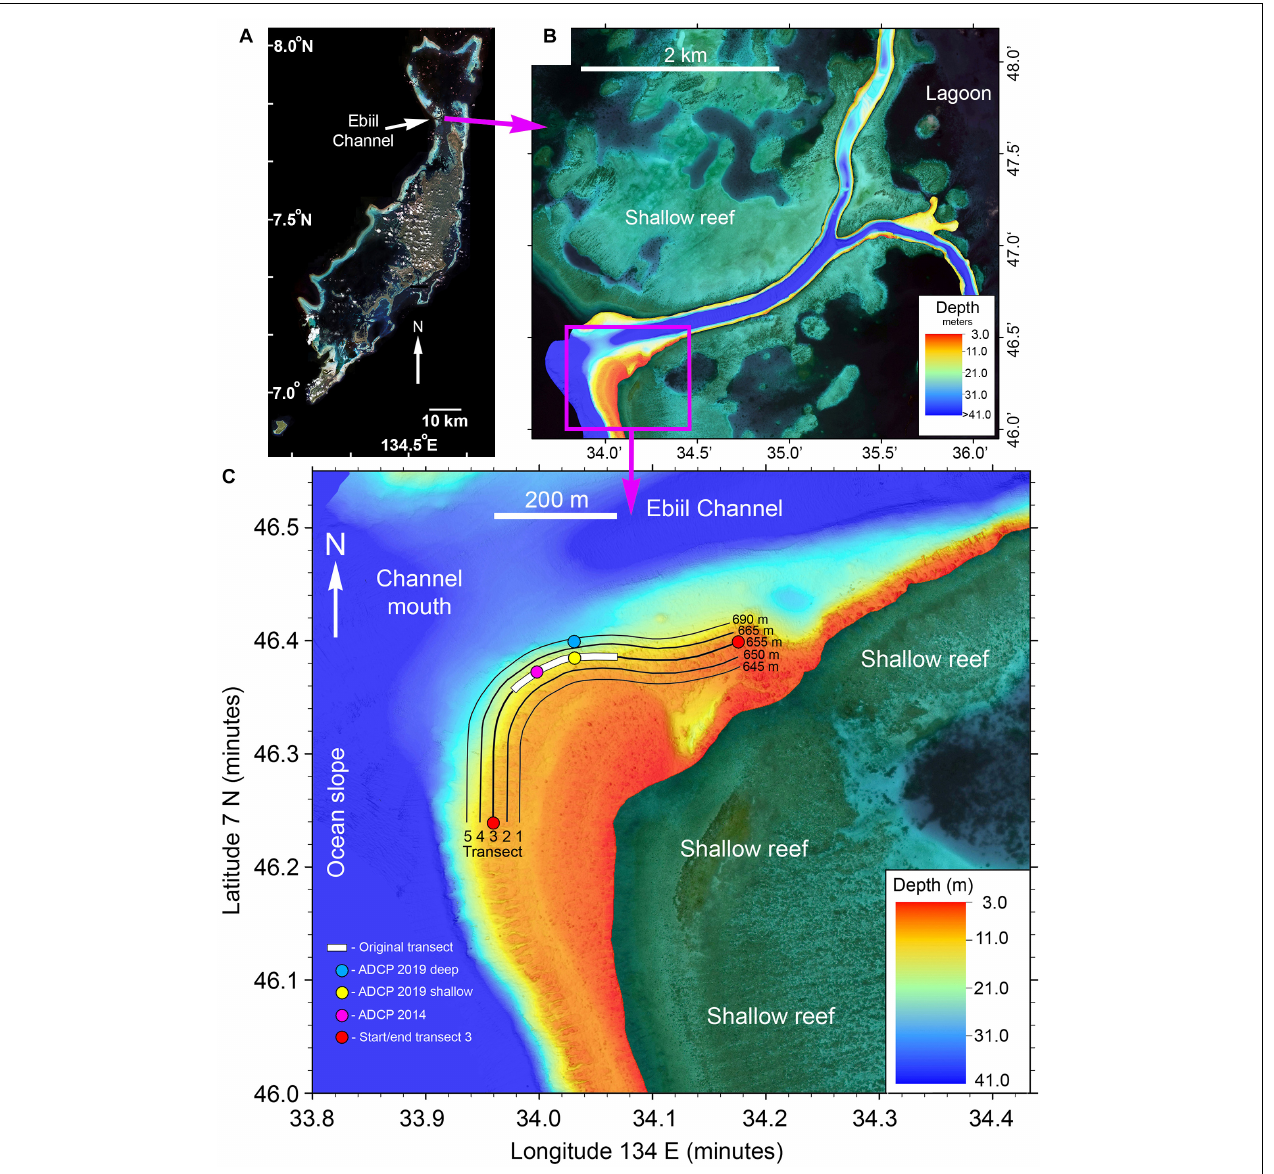
FIGURE 1 | (A) Satellite image of the main Palau reef tract with the location of Ebiil Channel indicated. (B) Multibeam sonar map of Ebiil Channel showing depths from ocean to lagoon. The detailed area shown below is indicated by the purple box. (C) Multibeam map detail of the aggregation area at the southern side of the Ebiil Channel mouth. The five numbered survey transects are indicated with their lengths. The ends of the central transect (3) are indicated by red circles. The extent of the 200 m long original transect, variously used by earlier researchers, along transect 3, is shown by the white bar. The locations of acoustic doppler current profilers (ADCP) are